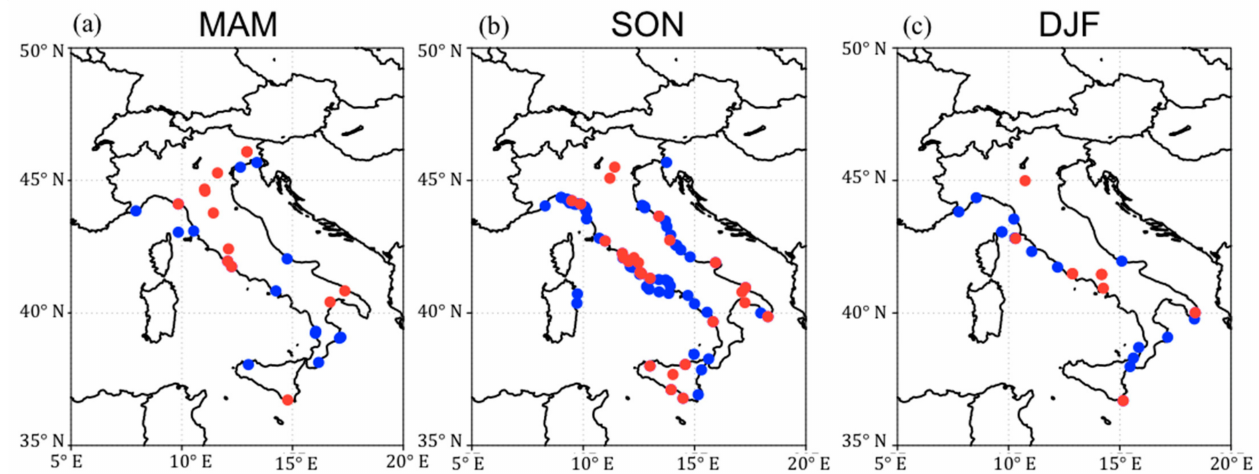
Figure 1. Geographical distributions of tornadoes associated with extratropical cyclones in ( a , left ) spring, ( b , middle ) autumn, and ( c , right ) winter. Tornadoes generated inland are shown in red, those generated as waterspouts are shown in blue.